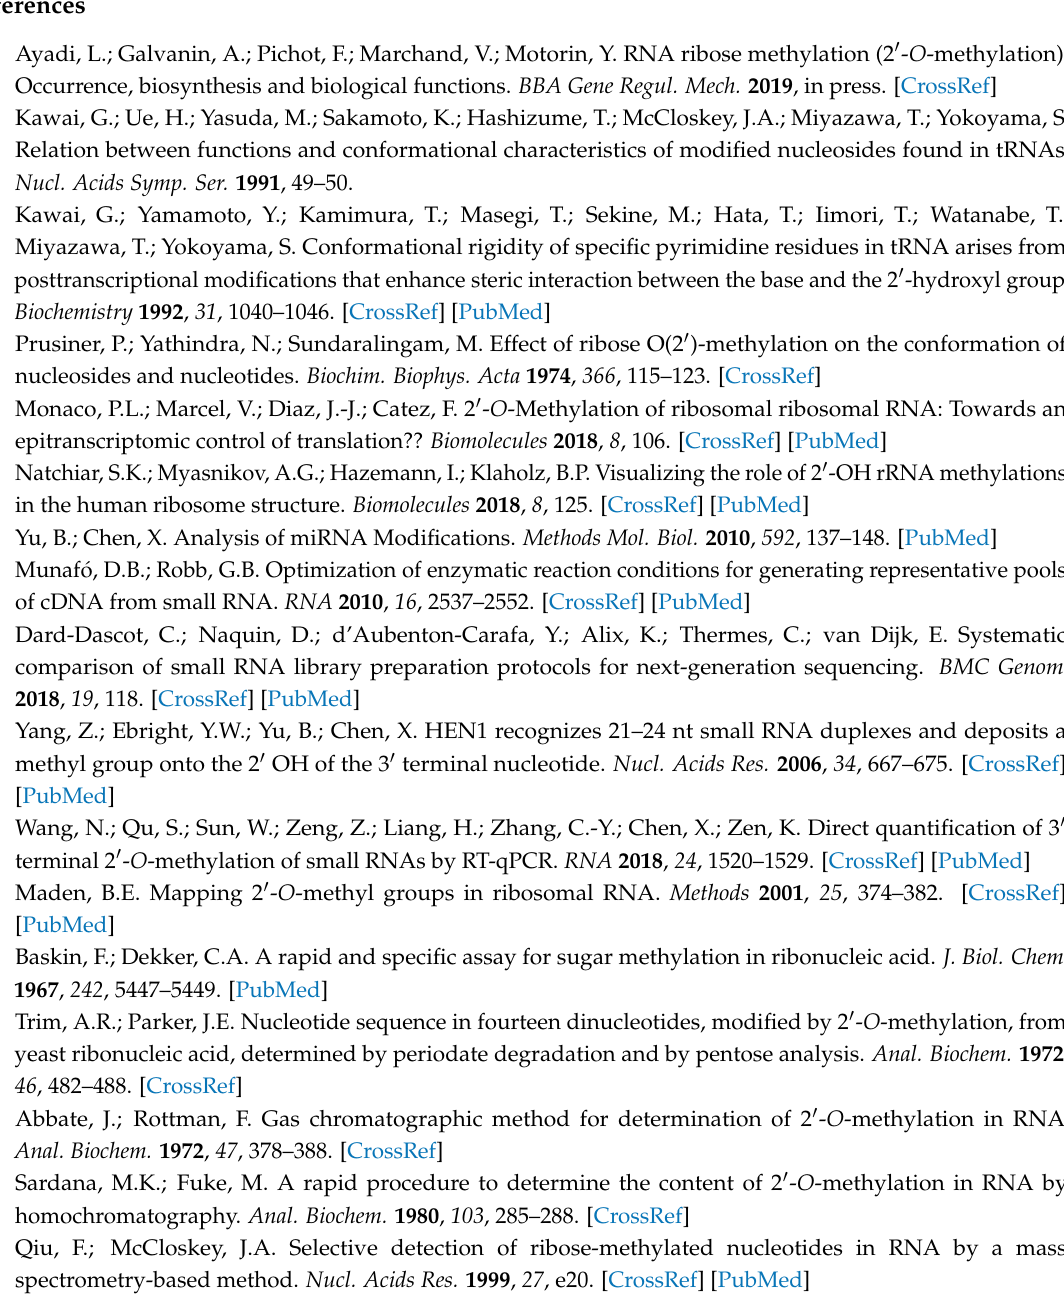
Figure S1: Comparative analysis of the 2 (cid:48) - O -methylation levels obtained by mass-spectrometry analysis and MethScore for the same position provided by various RiboMethSeq